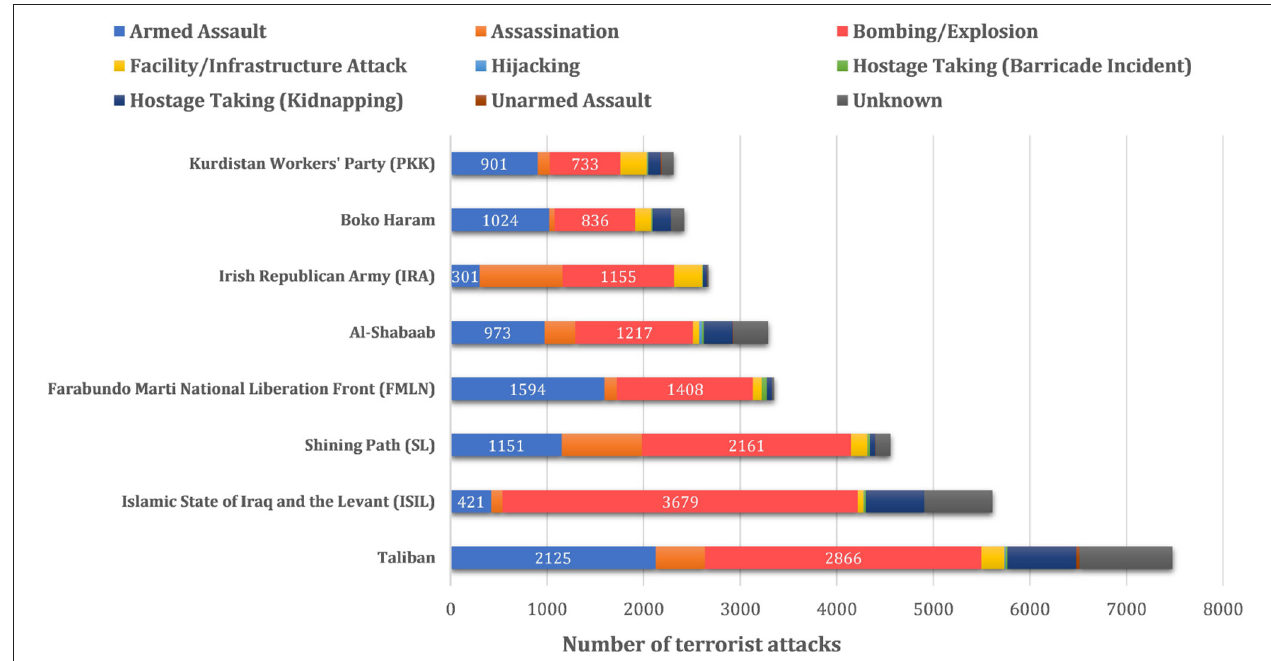
FIGURE 2 | Comparison of several terrorist organizations’ attack methods (Data source: GTD, 1970–2017, the total attack number of a specific terrorist organization is calculated by the times recorded in GTD’s variable gname , while the attack types statistics by attacktype 1_ txt